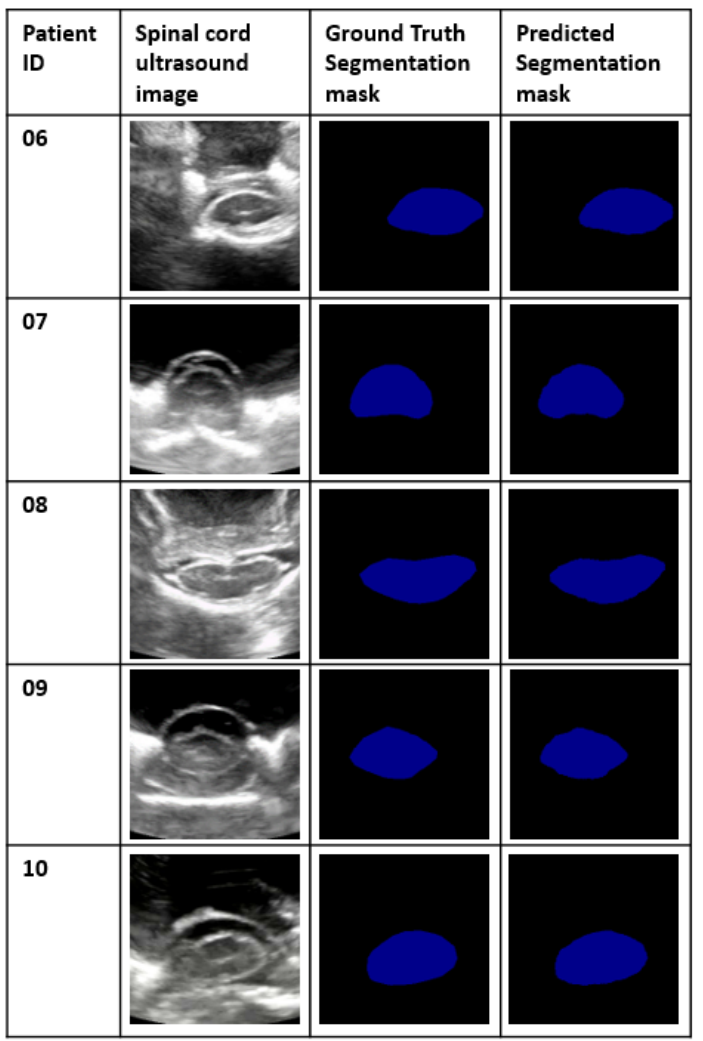
Figure 14. Samples from Dataset-A (patient 06 to patient 10), the ground truth and the predicted segmentation